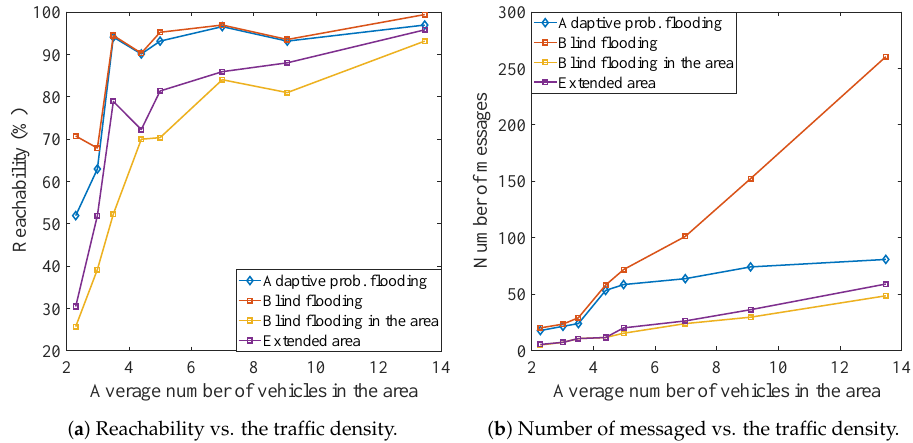
Figure 10. Comparison of the proposed adaptive probabilistic scheme with other hovering schemes in terms of the reachability achieved and the number of messages exchanged in area H for different average number of vehicles in the area.